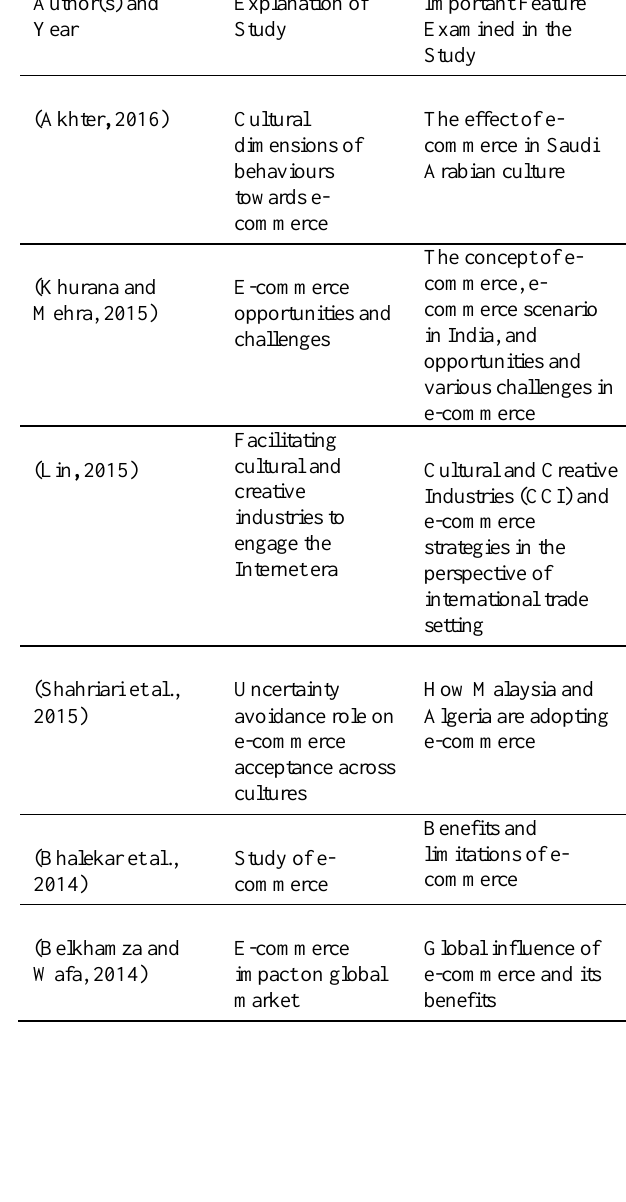
Table 2: A Summary of Research Regarding Correlations Between E-commerce, Culture, and Website Design